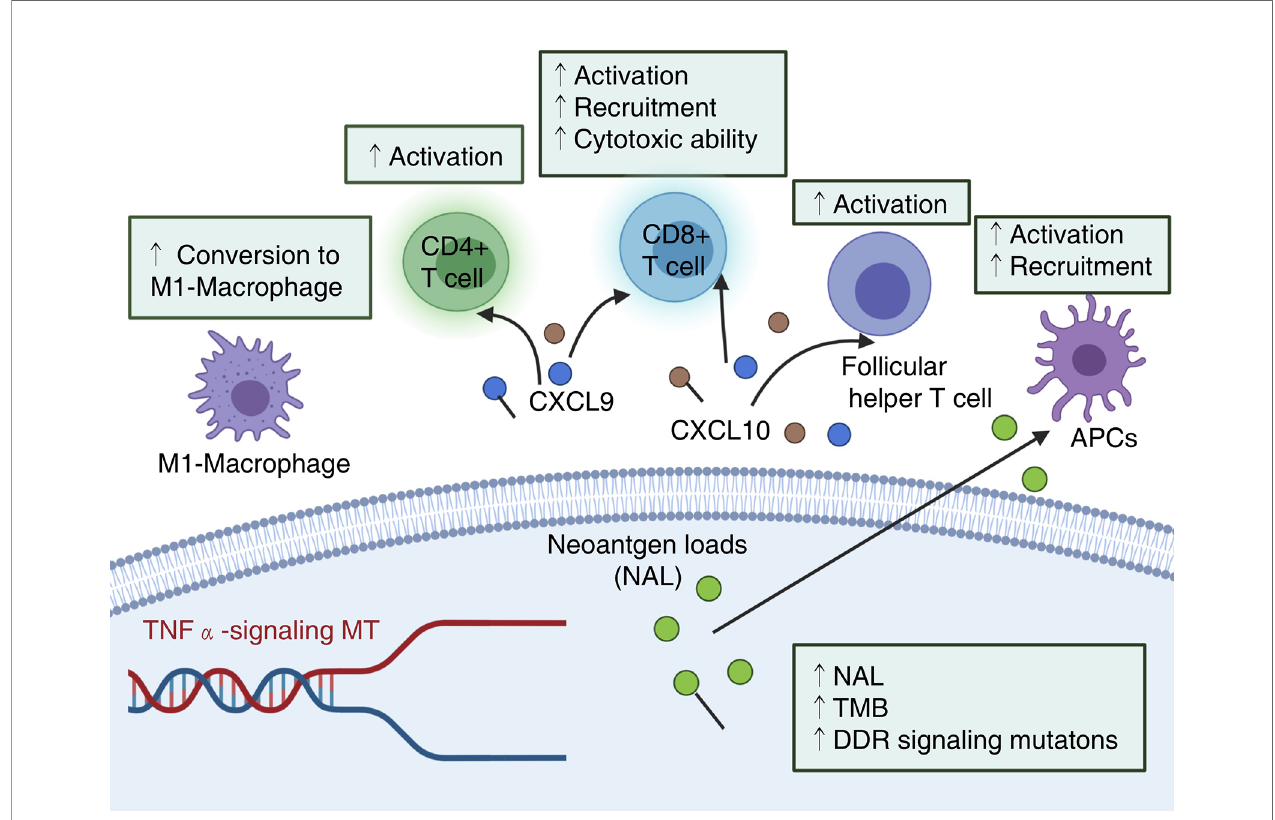
FIGURE 6 | Potential mechanism underlying the prognostic value of TNF a -MT. NAL, neoantigen loads; TMB, Tumor mutational burden; DDR, DNA damage